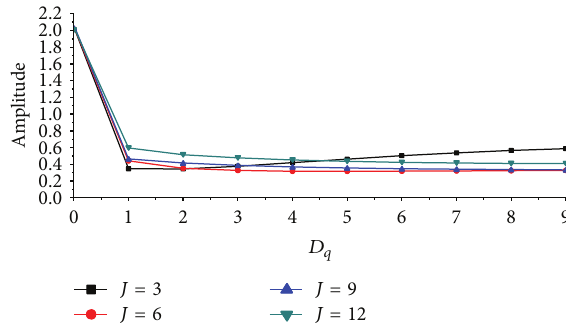
Figure 1: The generalized dimension curve of different grid